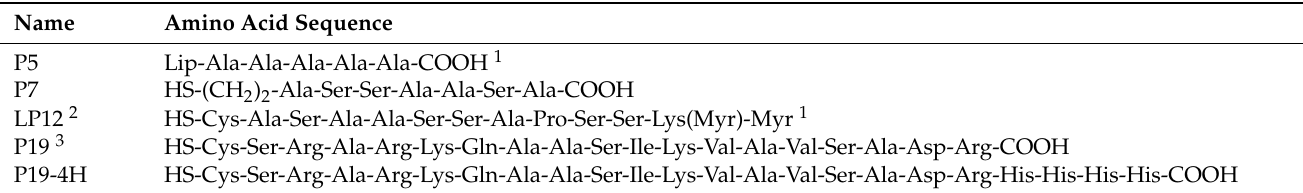
1 Abbreviations: ‘Lip’ for lipoic acid; ‘Myr’ for myristoic acid (C14:0). 2 LP12 is used like this, without additional chemistry. 3 Natural peptide corresponding to a part of α -subunit of laminin , a complex glycoprotein of the extracellular matrix, consisting of three chains α , β and γ able to interact with cellular receptors (e.g., integrins ) and implied in the cell attachment, differentiation, cell shape and motility